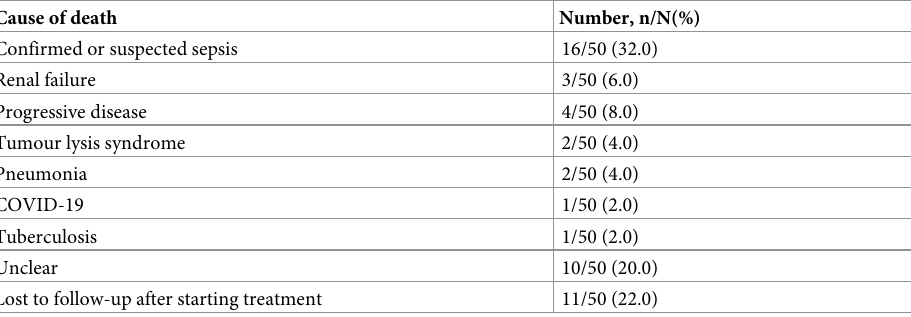
Table 2. Dominant causes of death.